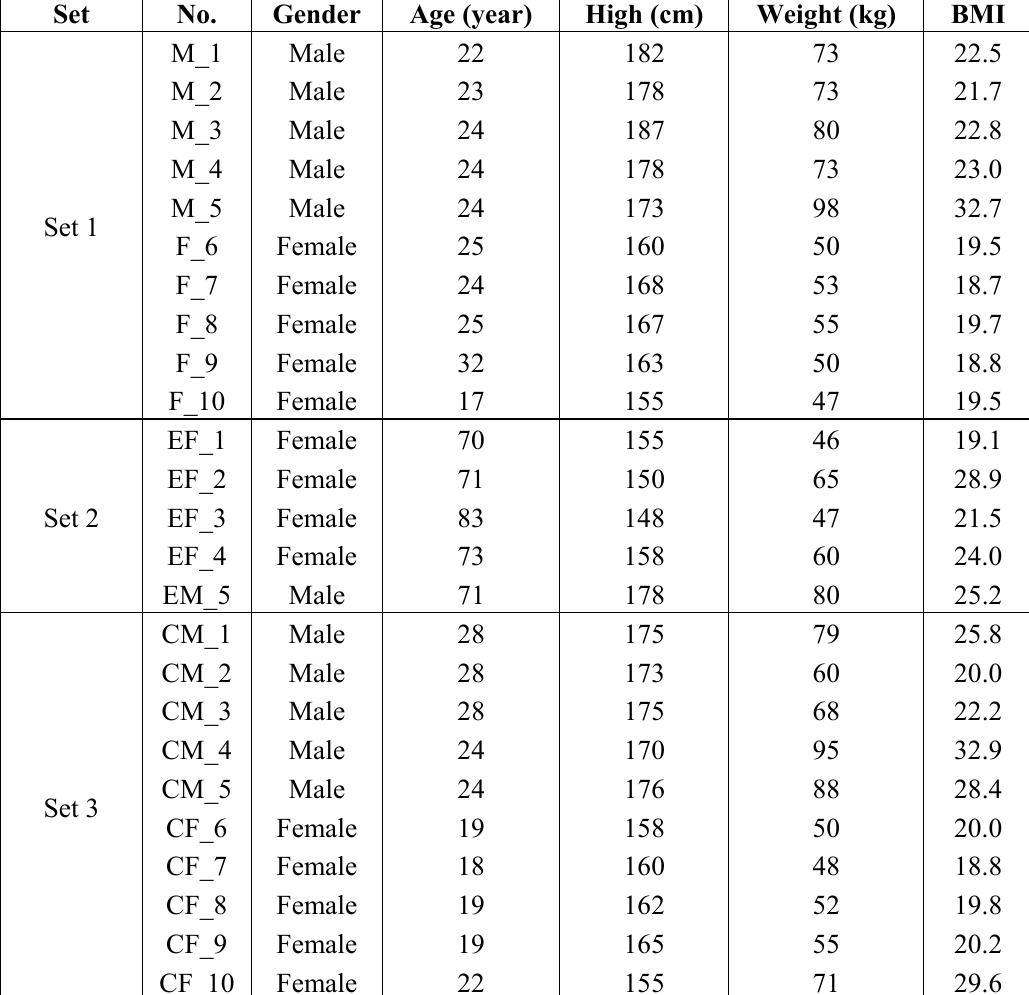
Table 1. Information on the volunteers for all of the